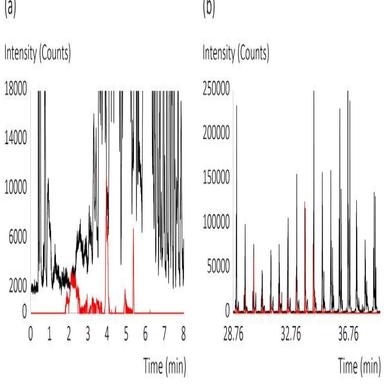
Separation of a full bio-oil sample in (a) 1D-SFC with ACN/MeOH (50/50, v/v) as co-solvent (1 μL injected) and (b) on-line RPLC x SFC (3 μL injected): BPC (black) and EIC 172.170 (red). Other analytical conditions given in 2.3.1. for 1D-SFC and in 1 for on-line RPLC x SFC.